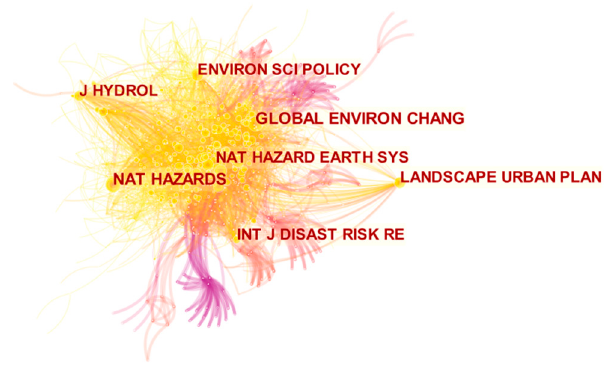
Figure 6. Journal cooperative network of the study of urban flood resilience 1999–2021.